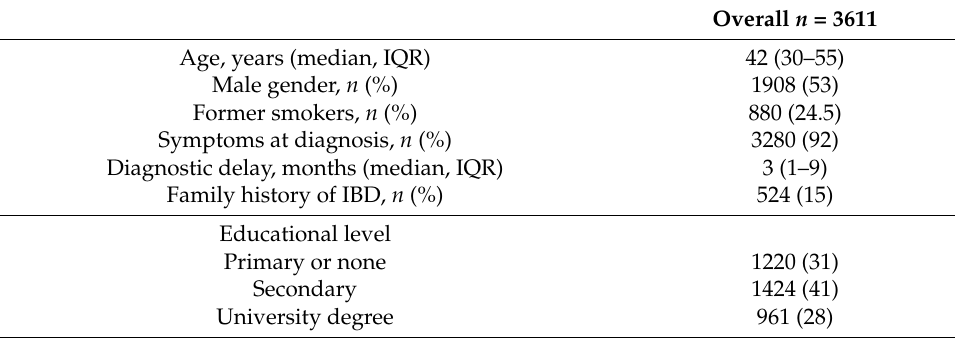
Table 1. Characteristics of the inception